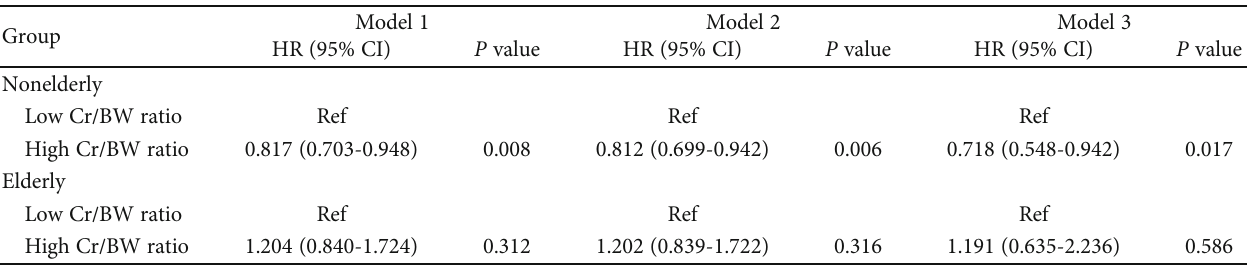
Table 5: Cox regression analysis for the association between the Cr/BW ratio and incident nonalcoholic fatty liver disease by